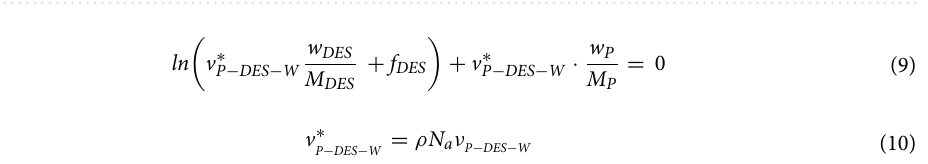
Figure 2. Extraction efficiency and partition coefficient for each studied 5-HMF in ATPSs. ChCl:lac (orange filled rectangle) ChCl:ox (blue filled rectangle) and ChCl:cit (red filled